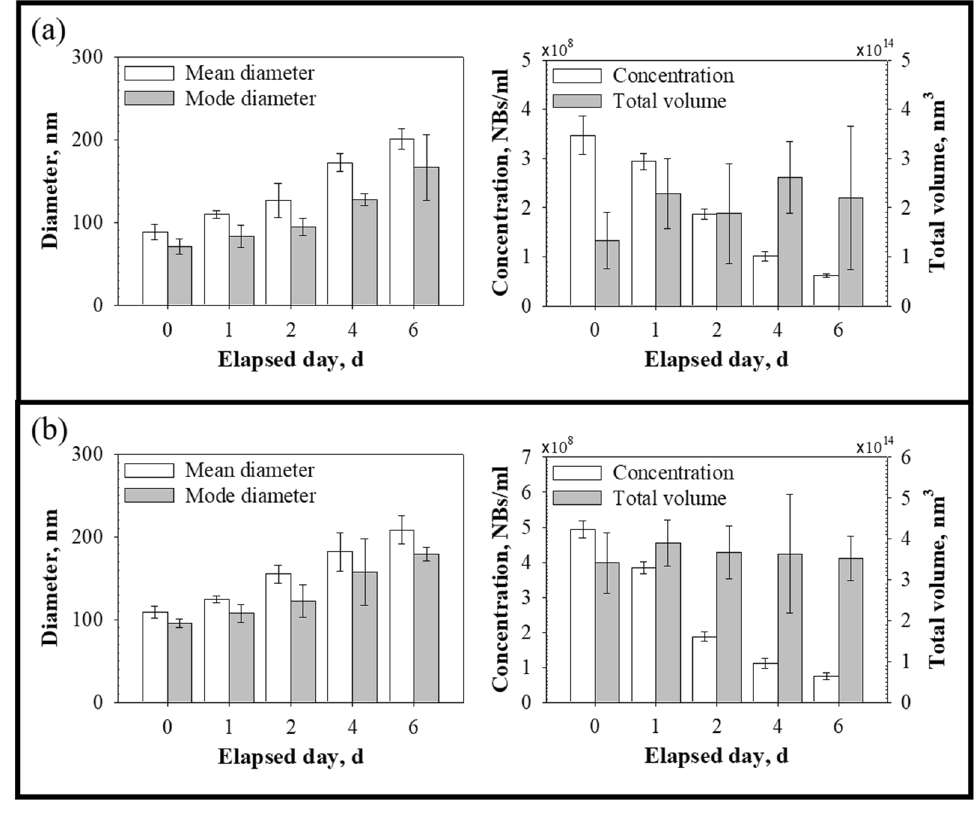
Figure 4. Diameters and concentration of BNBs in water. (a) Case 1, (b) case 2. The figures on the left are the mean and mode diameters, and the right side of the figures shows the concentration and total volume of BNBs.